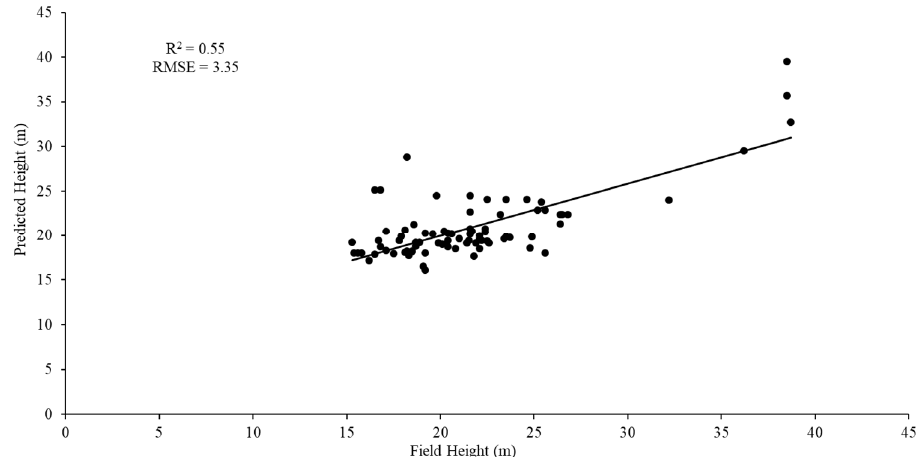
Figure 8. Validation of the canopy height map, based on the field observations.